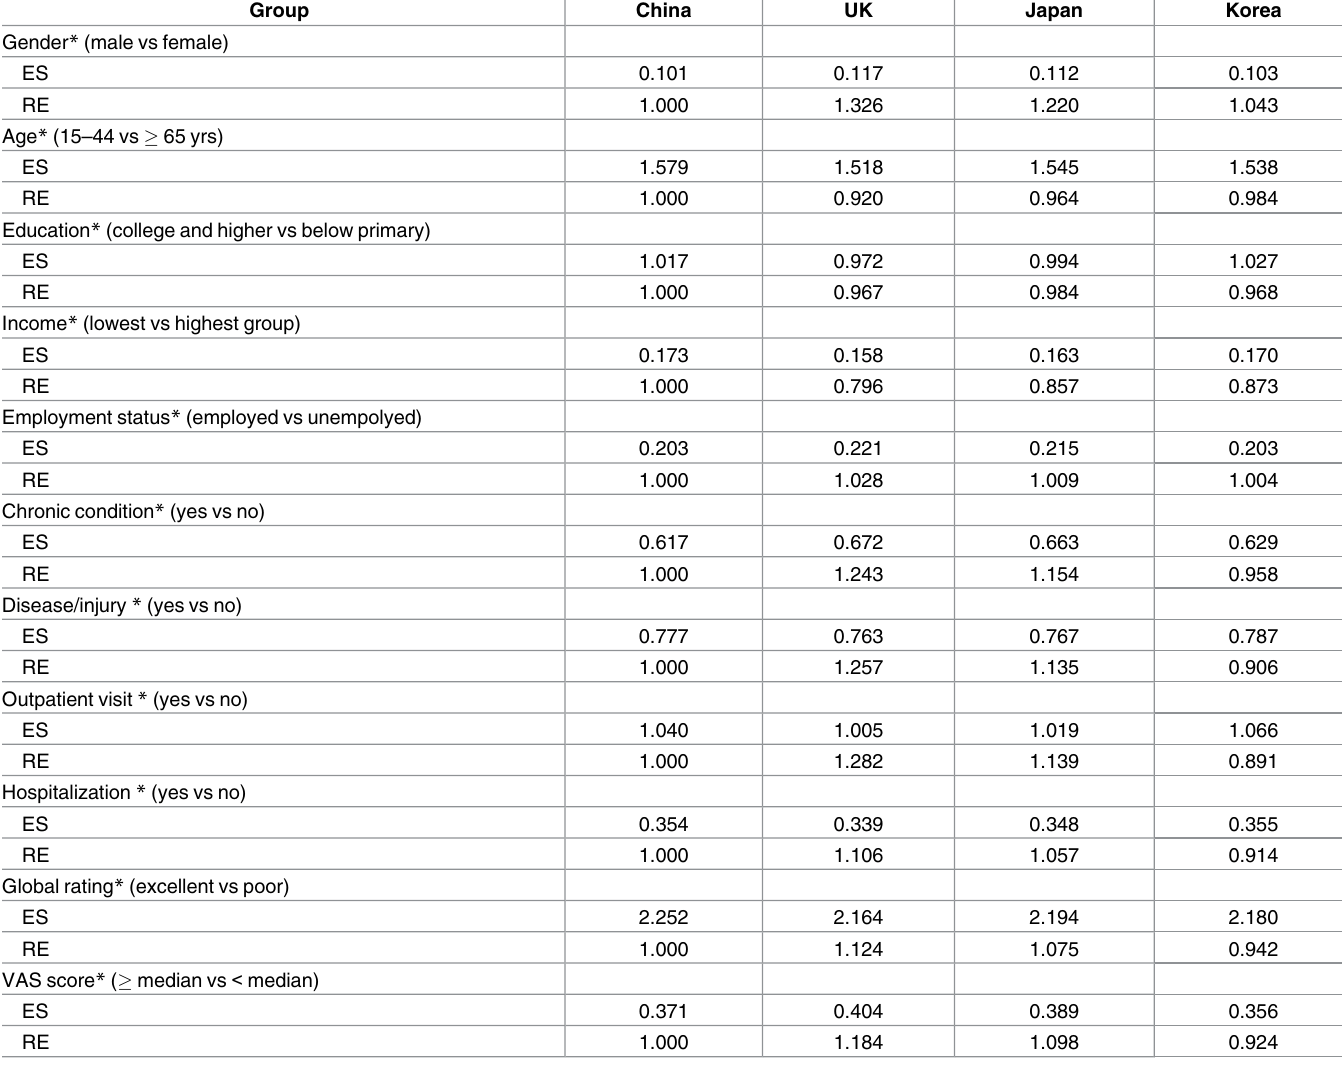
Table 5. Sensitivity of the EQ-5D index scores using China, UK, Japan and Korea weights.